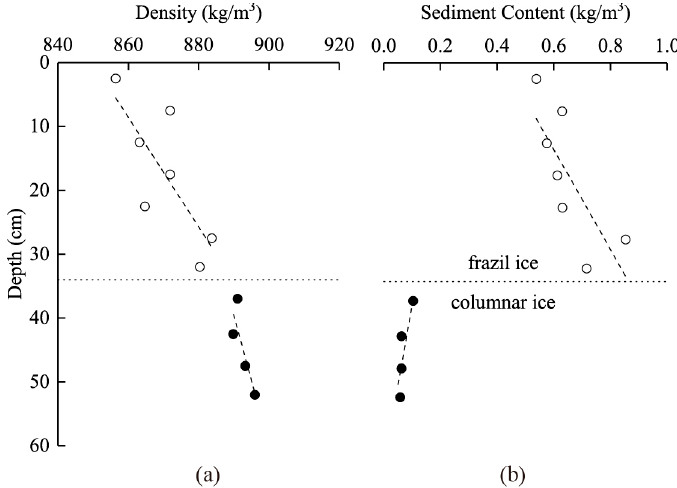
Figure 13. Variation in ice density and sediment content with depth: ( a ) ice density; ( b ) sediment content.